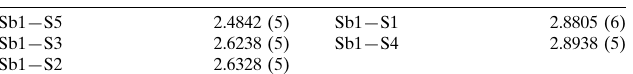
Selected bond lengths (A˚